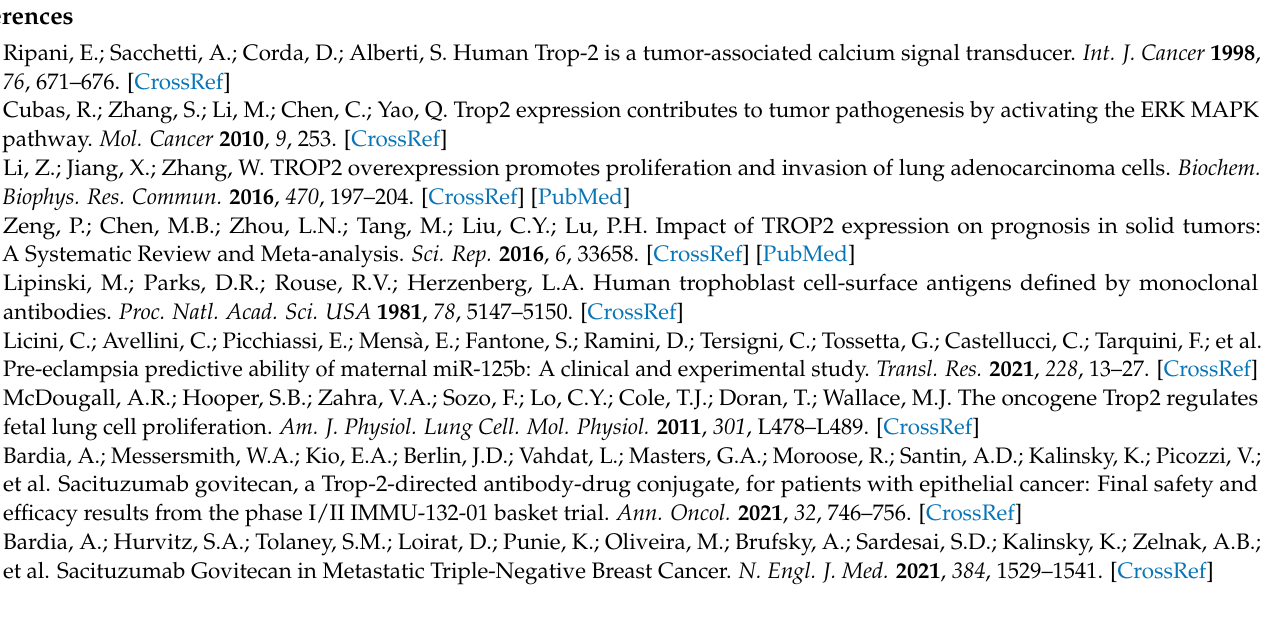
Figure S4: TROP2 expression was also compared with expression levels in other relevant carcinomas. (A) Breast carcinoma: All 50 investigated breast carcinomas were positive for TROP2 with partly different expression intensity (shown here two examples (A1 and A2) with strong expression). (B) Pan- creatic carcinoma. Of 50 tumors examined, 48 showed TROP2 expression. (B1) pancreatic carcinoma: positive (B2) negative (few tumor cells show very weak cytoplasmic labeling, which is considered an artifact). Figure S5: Further examples of TROP2 expression in esophageal adenocarcinoma (EAC). These illustrate the range of expression intensity and heterogeneity of TROP2 in EAC. (A) Indicates an EAC that shows strong membranous labeling of more than 80% of the tumor cells (this is present in the majority of EACs) (Score 3). (B) the EAC is much weaker and also only in single tumor cell groups TROP2 positive (Score 1). (C) is one example of the few tumors which are completely TROP2 negative EACs (Score